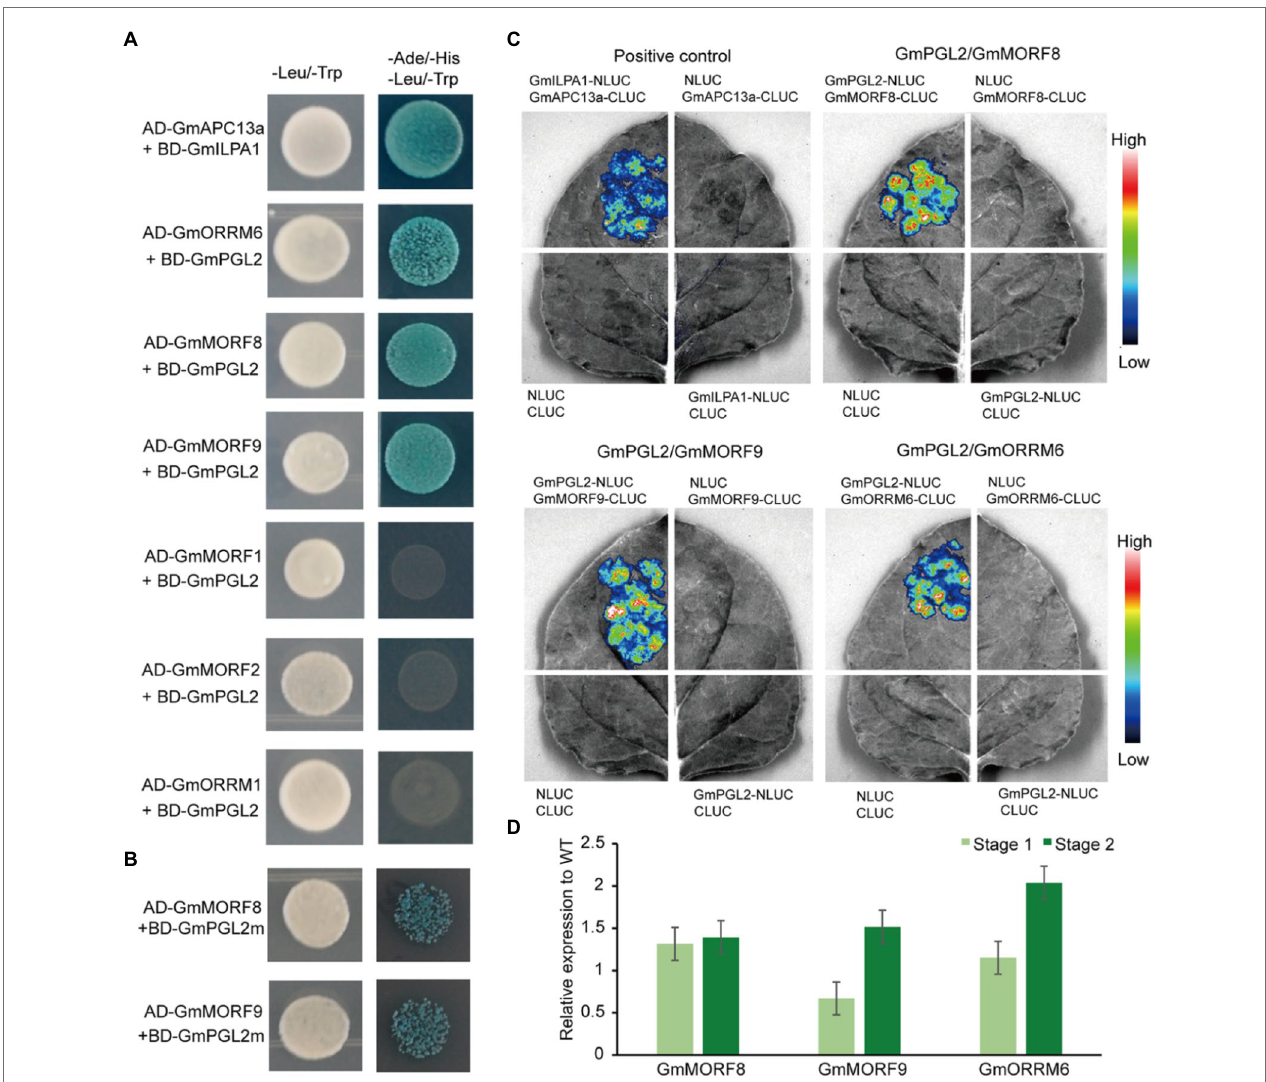
FIGURE 6 | GmPGL2 interacts with GmMORFs and GmORRMs. GmAPC13a and GmILPA1 represent the positive control. (A) Yeast two-hybrid assay between GmPGL2 and some GmMORFs and GmORRMs. (B) Yeast two-hybrid assay between mutated GmPGL2 (GmPGL2m) and GmMORF8, GmMORF9, respectively. (C) Luciferase complementation imaging was performed to confirm the interactions between GmPGL2 and GmMORF8, GmMORF9, and GmORRM6 in N. benthamiana, respectively. The fluorescent signal intensity represents the strength of interaction. (D) The expression levels of GmMORF8, GmMORF9, and GmORRM6 during two developmental stages of young leaves in wild type and Gmpgl2 . The values are the mean ratio ± standard deviation with three biological repeats. None significant difference was determined by Student’s t -test between wild type and